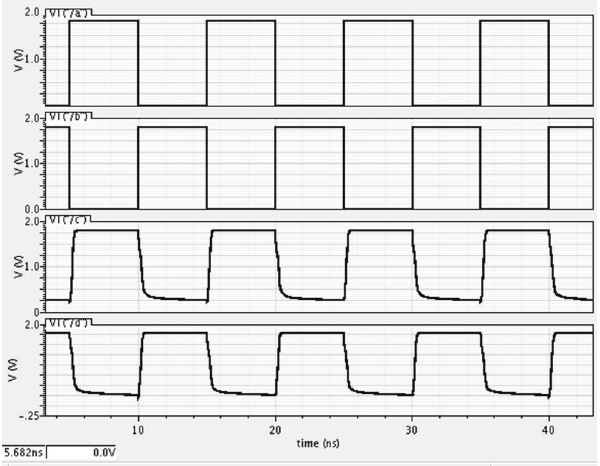
Figure 7: Simulated input and output waveforms of proposed DCVSL circuit using ULPD structure.